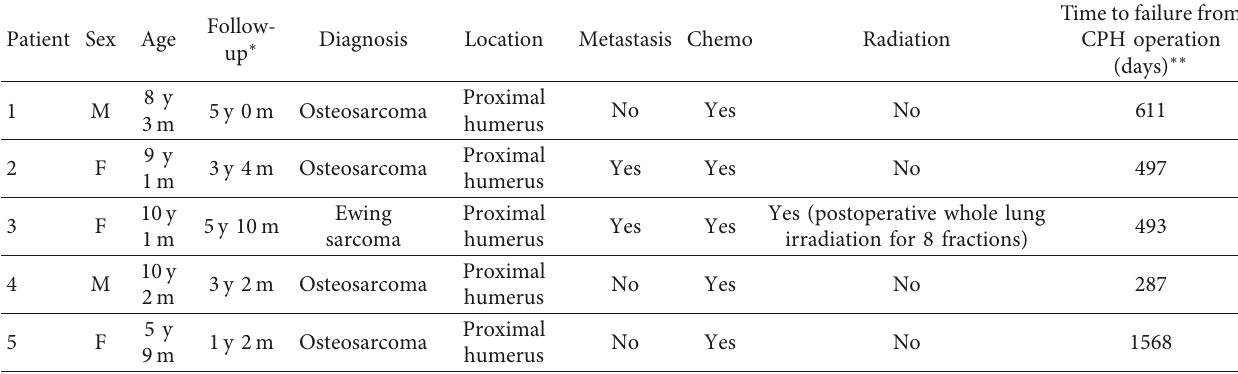
Table 2: Patient demographics and oncologic